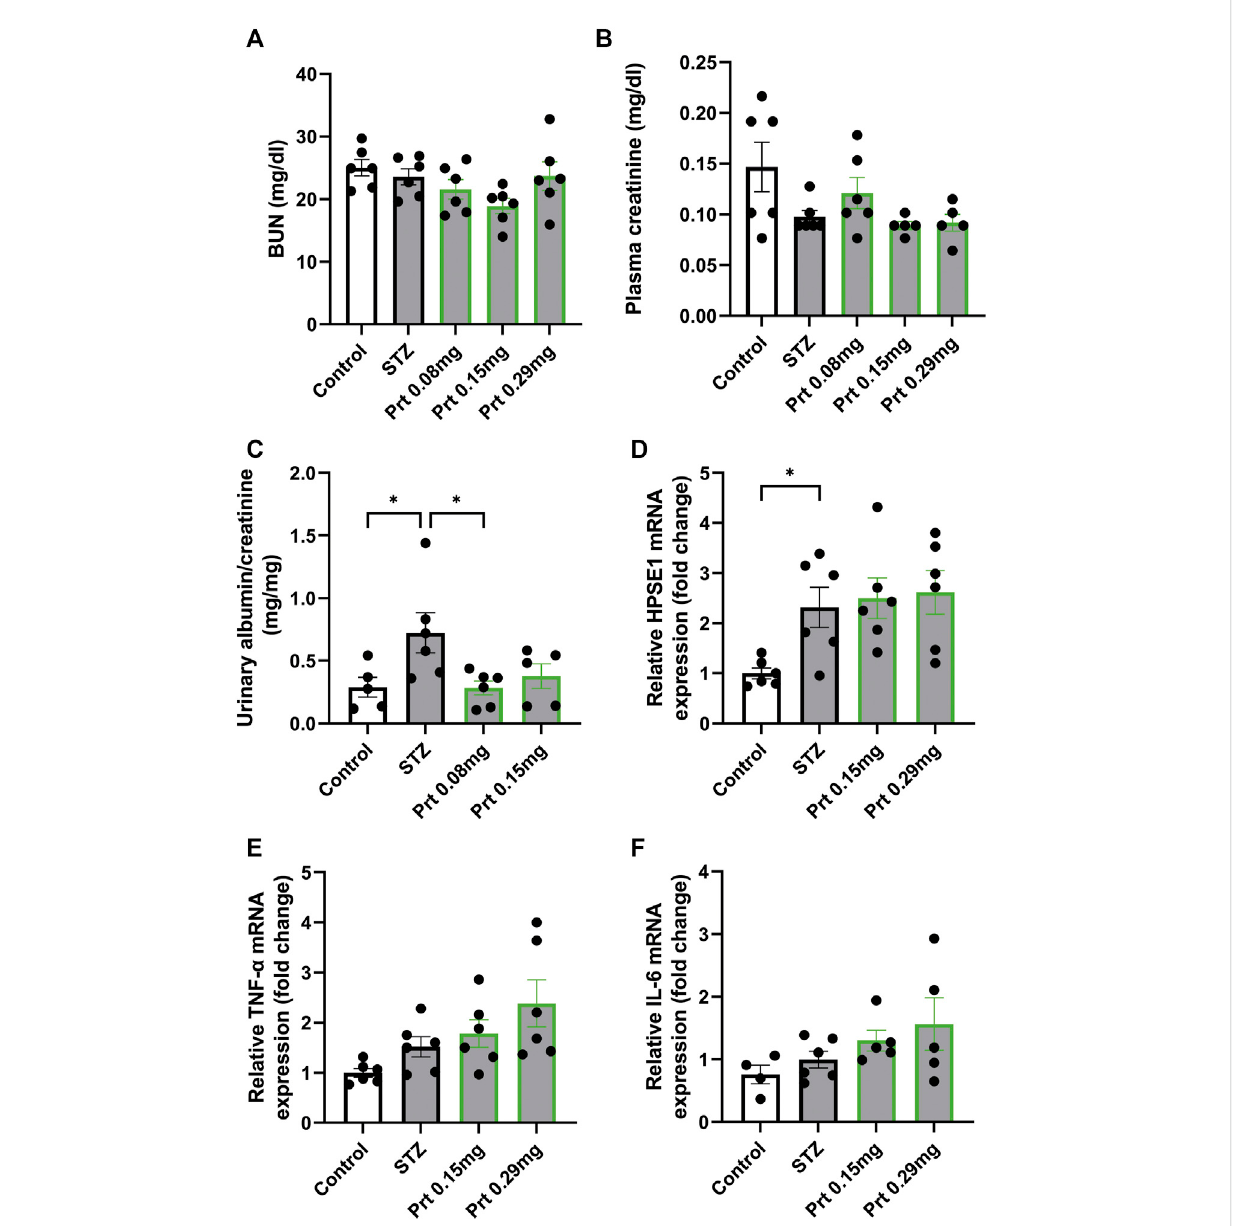
FIGURE 6 HPSE2 protein and peptides treatment bene fi cially affect experimental STZ-induced diabetic nephropathy (A) . BUN, (B) . plasma creatinine, and (C) . Urinary albumin/creatinine ratio of mice injected with STZ (12 weeks) and treated with different concentrations of HPSE2 protein or HPSE2 peptide mix (D) . Cortical HPSE1, (E) . cortical TNF- α , (F) . cortical IL-6 mRNA expression of mice injected with STZ (12 weeks) and treated with different concentrations of HPSE2 protein or HPSE2 peptide mix. Data are expressed as mean ± SEM. n ≥ 5 * p < 0.05. HPSE2, heparanase-2; HPSE1, heparanase-1; Prt,